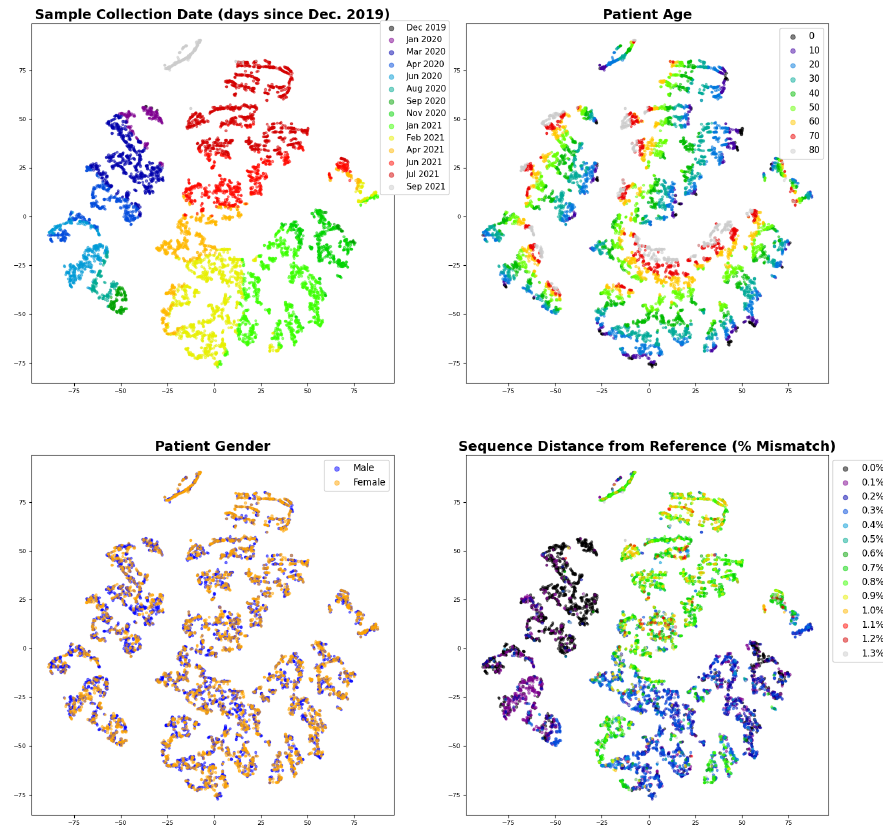
Figure 6. Sequence embeddings obtained from the trained neural network model and visualized based on a 2-component t-SNE (perplexity of 30). The plots all show the same t-SNE visualization of a random sampling of 150 samples each of the 45 most prevalent lineages in order to achieve sequence and sample date diversity. Clockwise starting with the upper left, the graphs show the t-SNE distribution labeled by sample collection date, patient age, sequence distance, and gender respectively. Variables are binned as indicated in the legend. Sequence distance is the number of mismatches between the sequence of the sample to the reference protein sequence divided by the reference protein sequence length, disregarding any padding or ambiguous amino acids in the sample sequence. The embeddings are heavily influenced by variant emergence and thus time, in addition to age. Gender has little